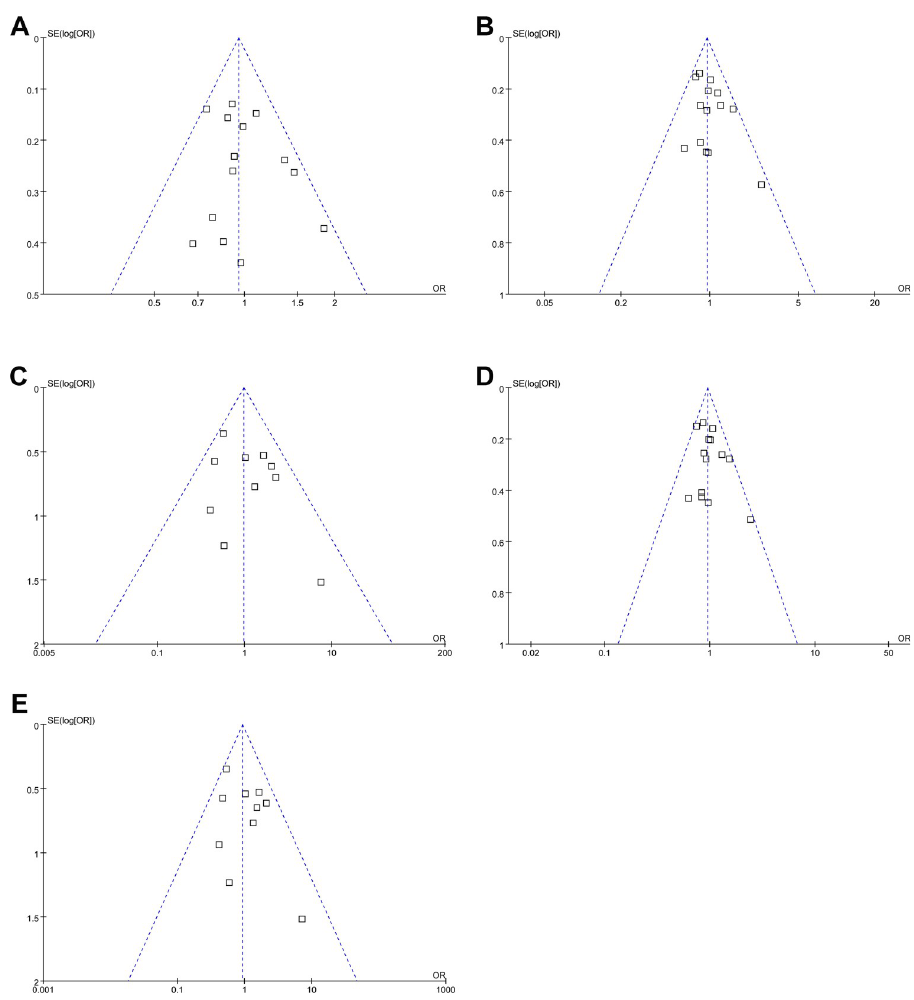
Fig 3. Funnel plots for the publication bias underlying the meta-analysis of the association between MTR A2756G polymorphism and CHD susceptibility in different genetic models. A, funnel plots for the meta-analysis under the allele model; B, funnel plots for the meta-analysis under the heterozygote model; C, funnel plots for the meta-analysis under the homozygote model; D, funnel plots for the meta-analysis under the dominant genetic model; and E, funnel plots for the meta-analysis under the recessive genetic